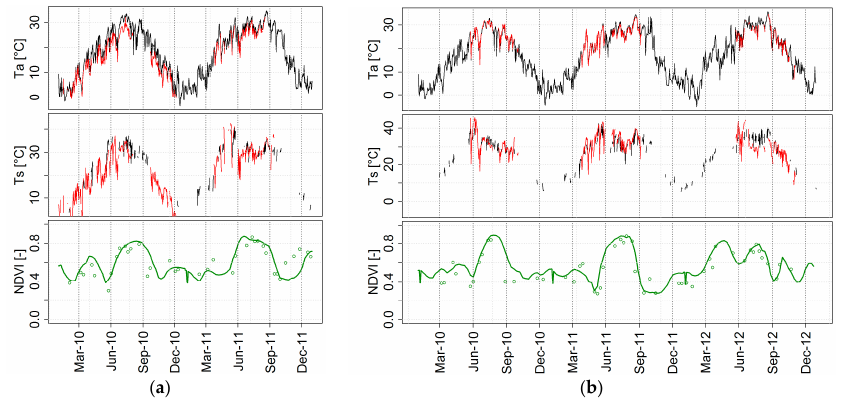
Figure 3. Time series of T a , T s and 250 m MODIS NDVI (dots for raw 8-day composite and daily smoothed) for the Landriano ( a ) and Livraga ( b ) sites. Black (red) lines show satellite/meteo (in situ) values.